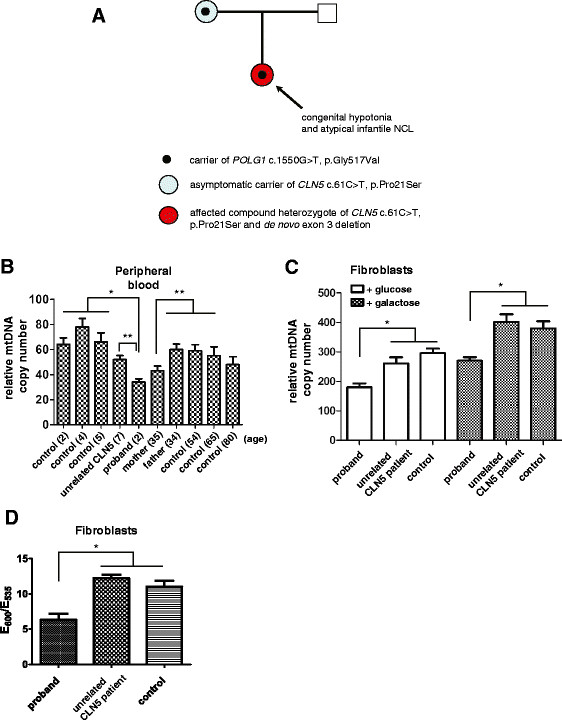
(A) Pedigree summarizing molecular analysis ofCLN5andPOLG1in proband and her parents. (B) Results of real-time PCR analysis of relative mtDNA copy number in peripheral blood from the proband, her parents, an unrelated CLN5 patient with a typical clinical course, and normal controls. Ages are noted in parentheses. Data are shown as the mean ± SEM of triplicate measurements; *, P < 0.01, **, P < 0.05, two-tailed t test. (C) Relative mtDNA copy number in cultured skin fibroblasts from the proband, unrelated CLN5 patient, and normal control (GM8330). Fibroblasts were grown under standard conditions (25 mM glucose) or under conditions of metabolic stress (25 mM galactose). Data are shown as the mean ± SEM of triplicate measurements; *, P < 0.05, two-tailed t test. (D) Measurement of relative mitochondrial membrane potential using the ratiometric dye JC-1 in fibroblast lines from the proband, an unrelated CLN5 patient with a typical clinical course, and a normal control subject (GM8330). E600 is the emission peak corresponding to normal mitochondrial polarization; E535 is the emission peak corresponding to depolarization. Data are shown as the mean ± SEM of triplicate measurements; *, P < 0.01, two-tailed t test.